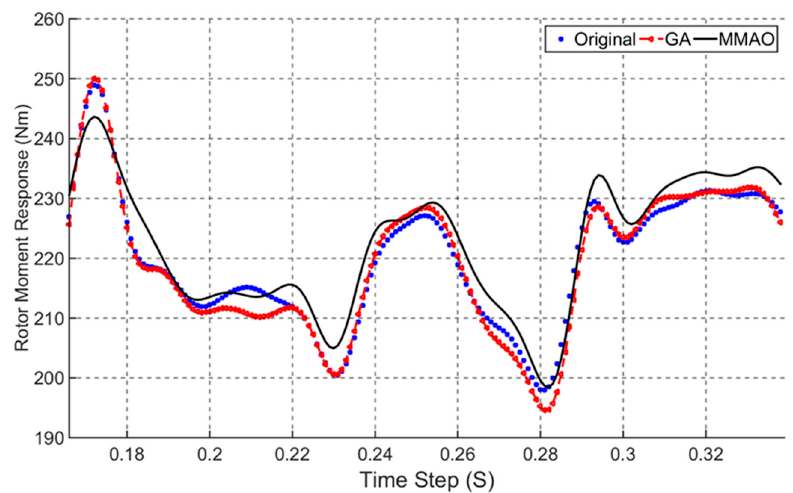
Figure 15. Moment responses from the entire rotor blade surface.